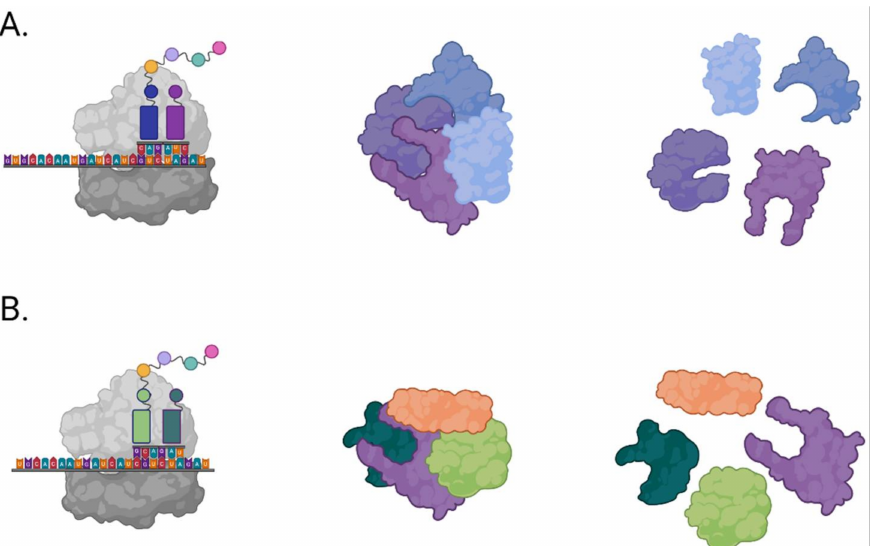
Figure 3. Coronavirus initial translation and polyprotein cleavage. Upon the release of the coro- navirus RNA genome into the host cytoplasm, host ribosomes initiate the translation of viral pro- teins. ( A ) Translation of the viral genome results in expression of viral polyprotein pp1a, which encodes essential viral proteases that cleave the viral polypeptides into individual functional proteins. ( B ) Programmed translation frameshift results in expression of viral polyprotein pp1ab, which is cleaved by the expressed essential viral proteases into individual functional proteins. Note: fig- ure is an illustration, not an accurate depiction of coding sequence or protein structure. Created with